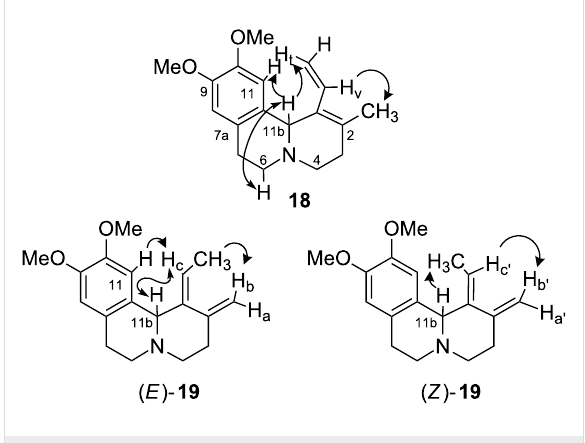
Figure 1: Key NOE interactions. 18 : 11b-H/11-H, 11b-H/6-H, 11b-H/H t , H v /2-CH 3 ; E - 19 : H b /CH 3 , H c /11b-H, H c /11-H; Z - 19 : H b’ /H c’ , 11b-H/CH 3 .